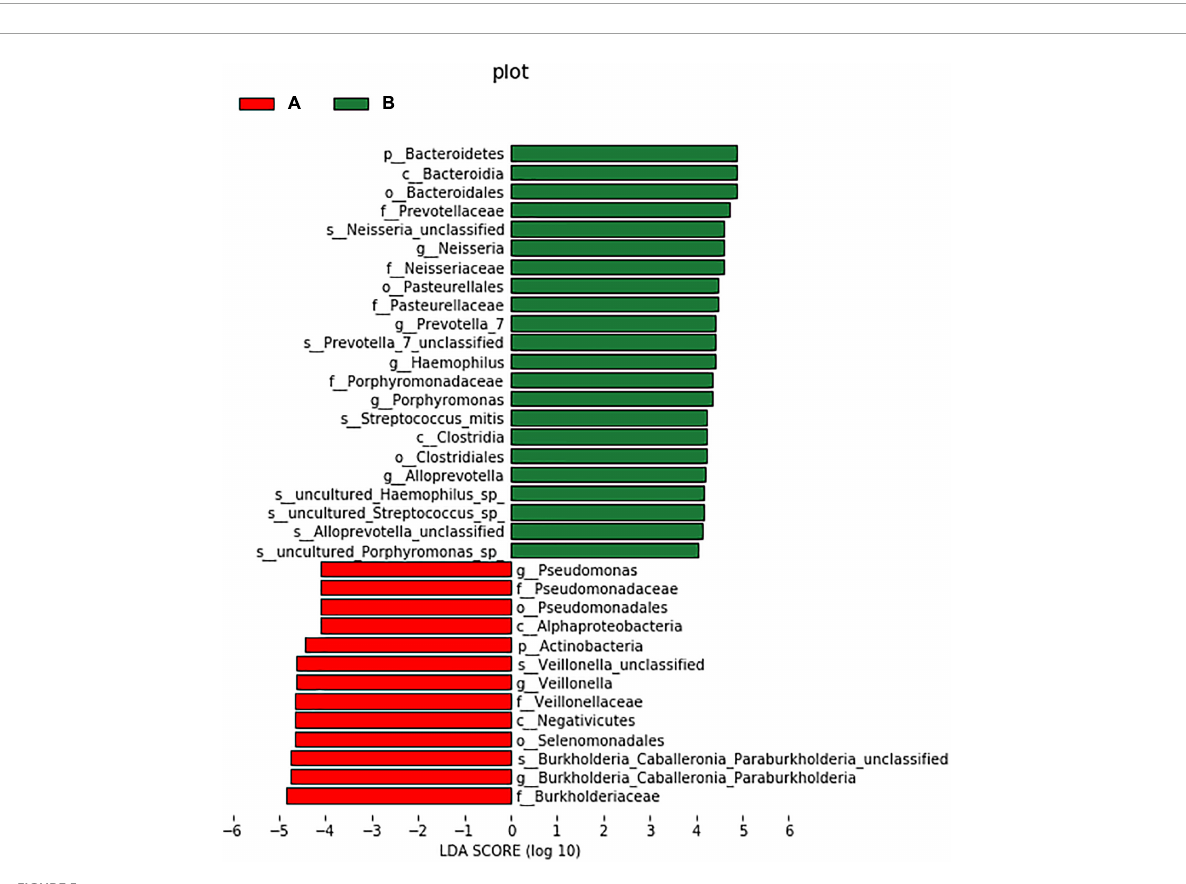
FIGURE5 Histogram of the LDA value distribution of significantly different species.